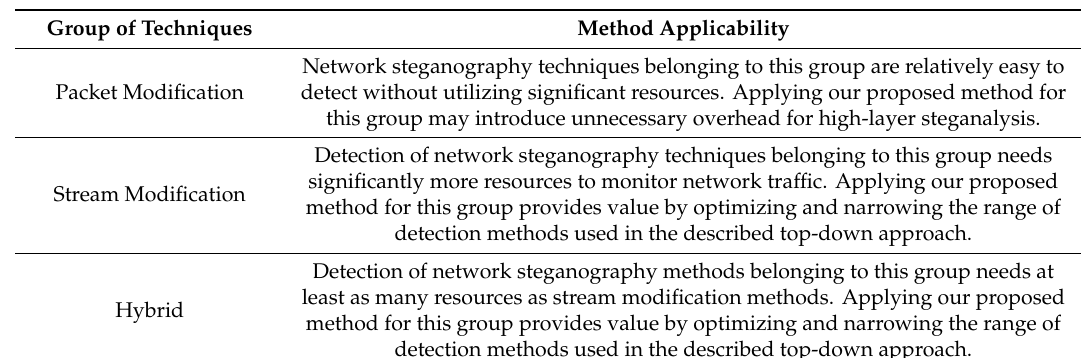
Table 1. Applicability of detection